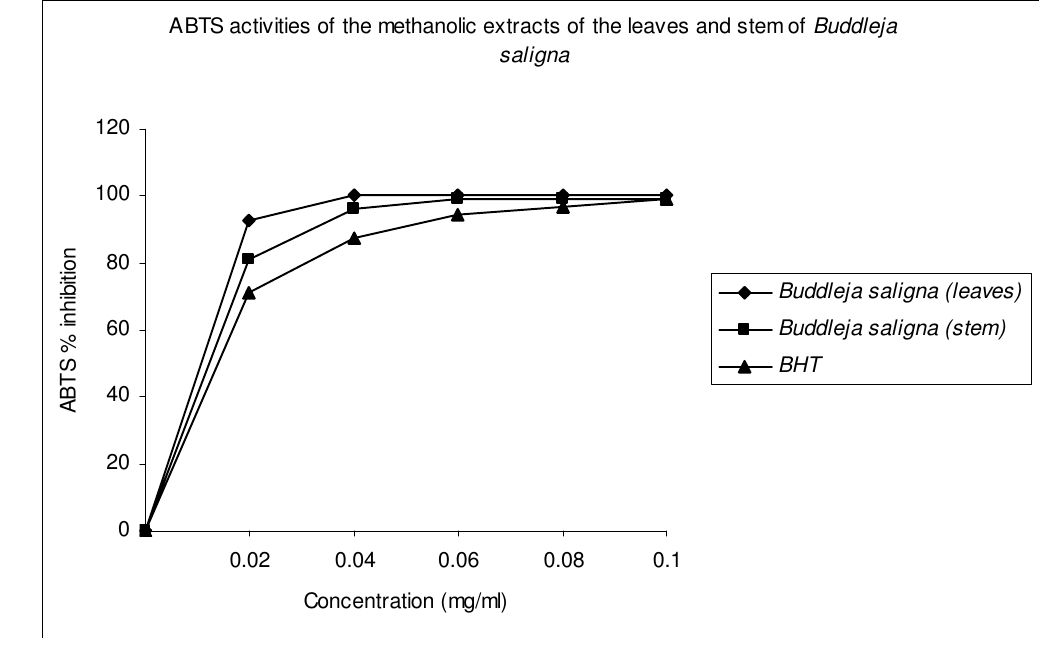
Figure 2 ABTS activities of the methanolic extracts of the leaves and stem of Buddleja saligna